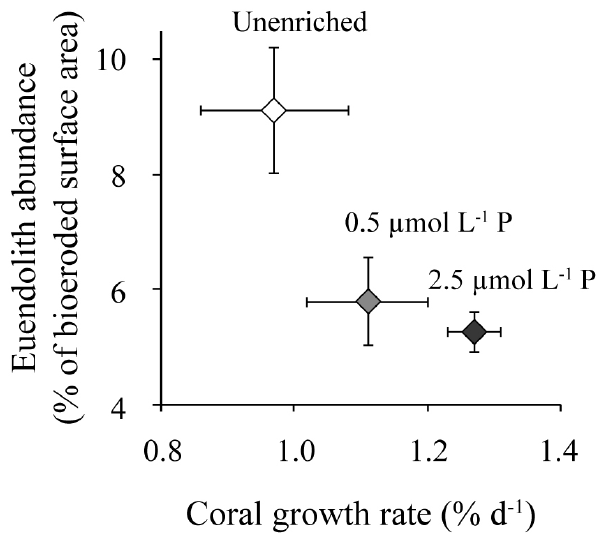
Fig. 4. Relationship between coral skeletal growth rates and the abundance of euendoliths. Skeletal growth rates are from Godinot et al. (2011a) and were measured over 8 weeks of phosphate enrich- ment. Abundance of euendoliths was estimated based on the per- centages of surface area bioeroded in each phosphate treatment after 15 weeks of exposure to phosphate treatments. Data are presented as the means ± SE, with n = 5 samples per phosphate treatment for the abundance, and n = 10 for growth